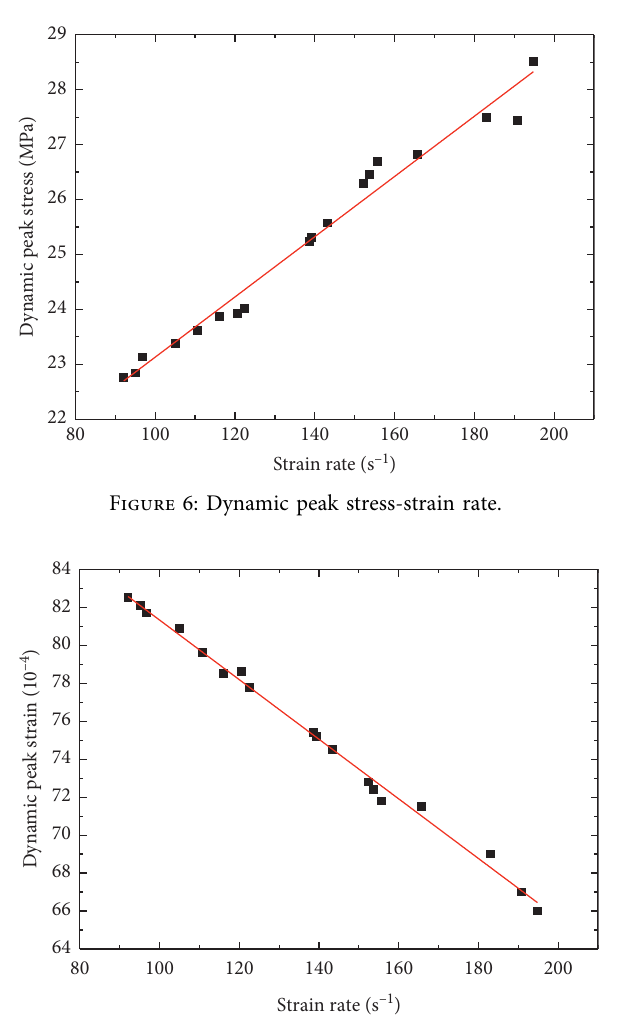
Figure 7: Dynamic peak strain-strain